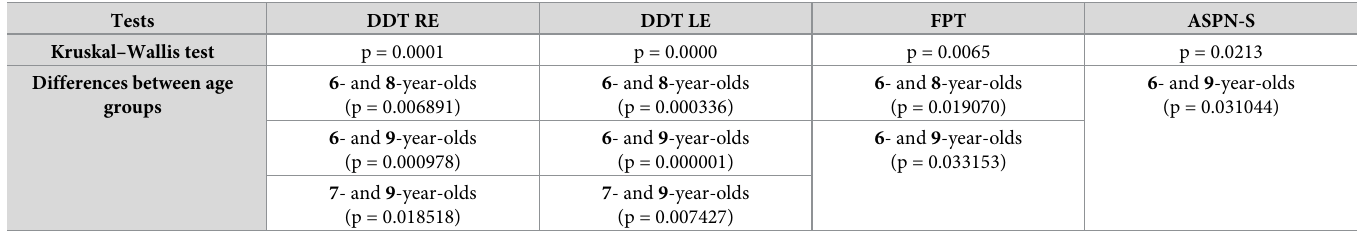
Table 9. Analysis of differences between age groups for the APD test results in group”C”, with the application of the post hoc (multiple comparisons test of mean ranks for all samples) tests. Tests DDT RE DDT LE FPT ASPN-S Kruskal–Wallis test p = 0.0213 Differences between age groups